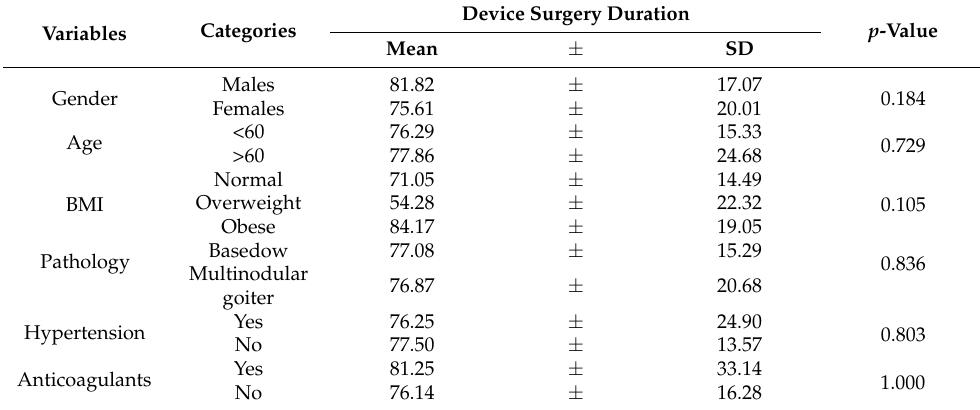
Table 7. Analysing variables influencing Surgery duration for Device group. Abbreviation: BMI: Body Mass